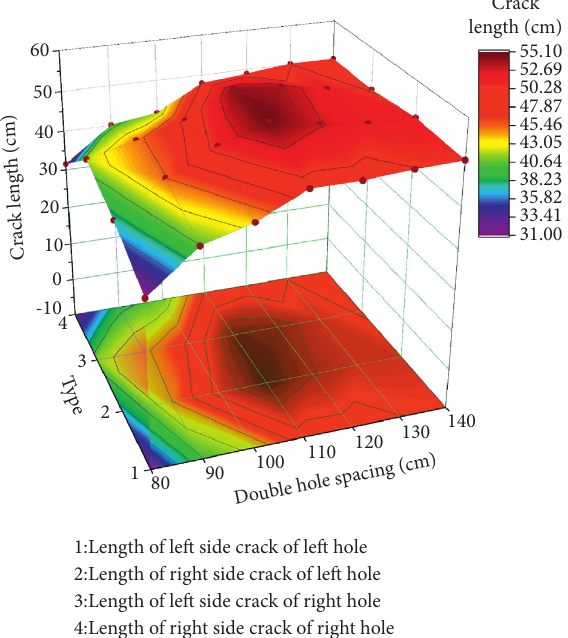
Figure 19: Crack length under different drilling spacing.